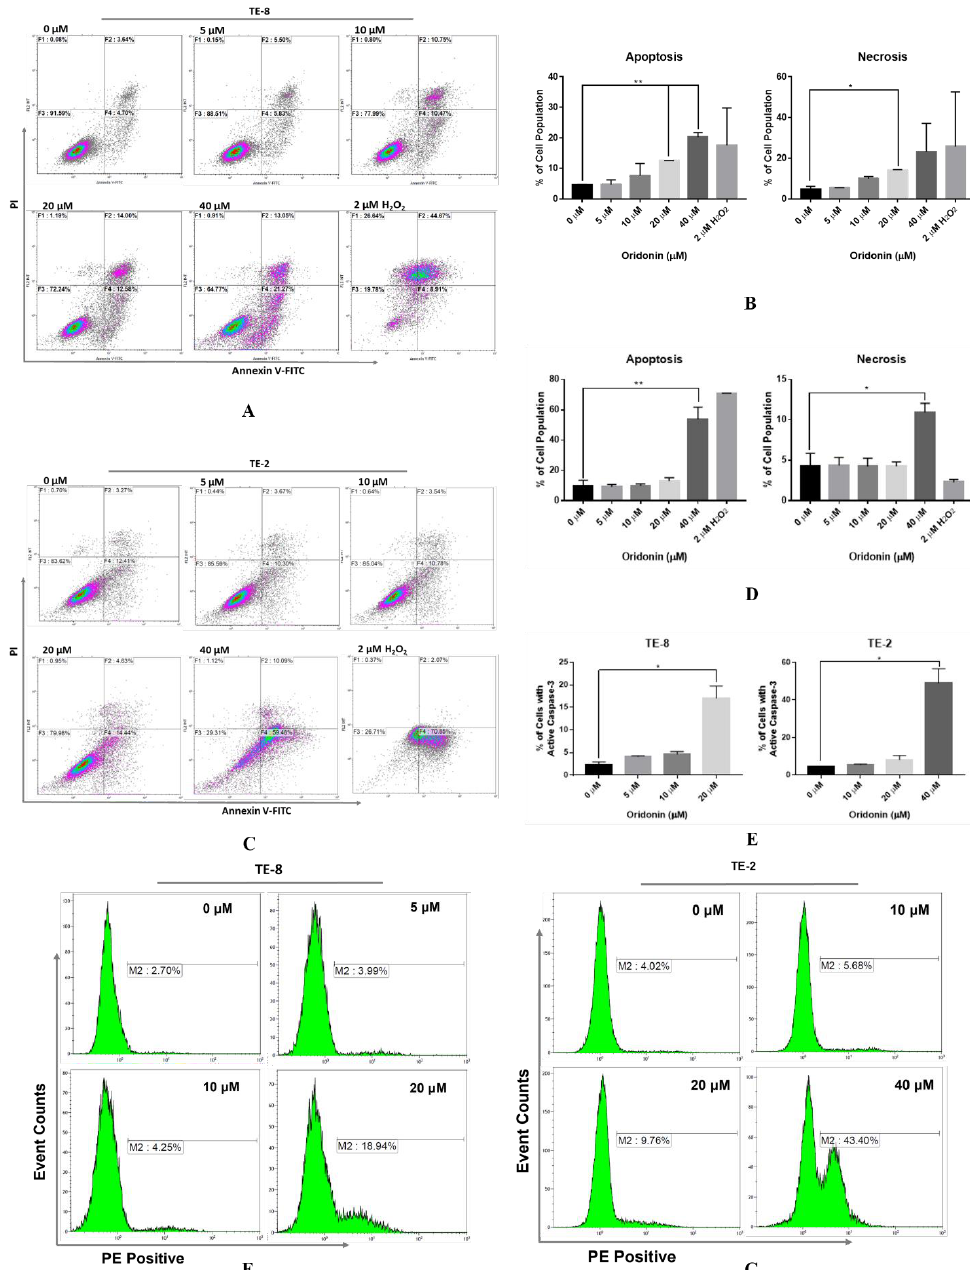
Figure 4. Oridonin induces phosphatidylserine externalization and caspase-3 activation on TE-8 and TE-2 cell lines. ( A ) Oridonin leads to TE-8 cells dose-dependently accumulated in early- and late-stage/necrosis apoptosis with treatment for 24 h. ( B ) The percentages of early apoptosis treated with 20 and 40 µ M oridonin and late-stage/necrosis apoptosis treated with 20 µ M oridonin on TE-8 were significantly different from the negative control. ( C ) Oridonin causes apoptosis of TE-2 cells after 48 h treatment although concentration-dependent was not observed. ( D ) The percentage of early-apoptosis upon 40 µ M oridonin treatment on TE-2 was markedly different to the negative control. ( E ) Compared to the negative control, oridonin treatment under 20 and 40 µ M on TE-8 or TE-2 cell lines for 48 h showed significantly activated caspase-3. ( F ) 20 µ M oridonin induces caspase-3 activation on the TE-8 cell line. ( G ) 40 µ M oridonin induces caspase-3 activation on the TE-2 cell line. Results are presented as mean + SEM from two independent experiments. The H 2 O 2 treatment was a positive control. The 0.08% DMSO in the complete medium labeled as 0 µ M was the negative control. (* p < 0.05, ** p <